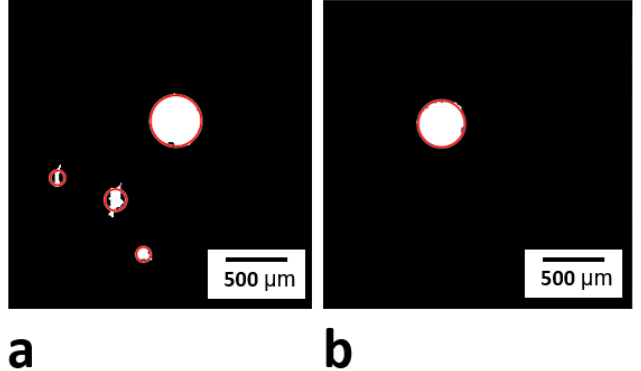
Figure 8. Image of the morphologically processed ( a ) silica and ( b ) alumina inclusion with the red circle drawn from the diameter calculated as described by the steps in the Section 2.